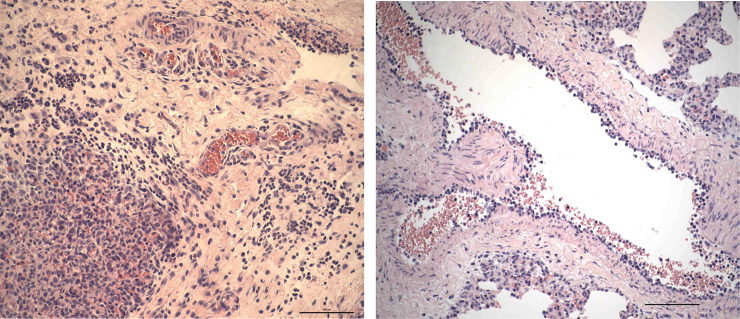
Histology of lung samples, AF-16 vs control.3A Intense inflammatory cell reaction shows leukocytes rich in polymorphs in the alveoli (down, at left) and in the capillaries in the interlobular septum (AF-16). 3B Bronchial vessel shows leukocytes adhering at the endothelium. It could be an early stage in the process of leukocyte migration through the vessel wall, but leukocytes seem to remain in the intima which is suggestive of endoarteriolitis, which could be predisposing for thrombosis (control).